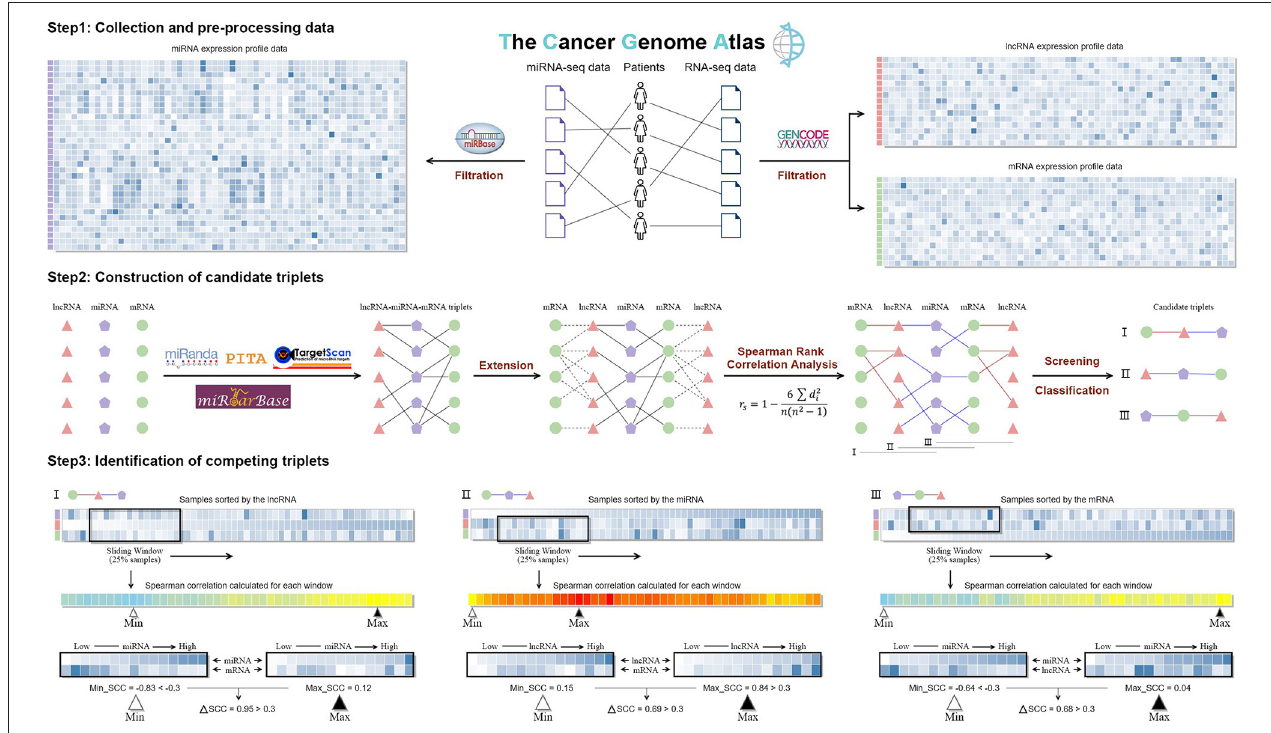
FIGURE 1 | The workflow of